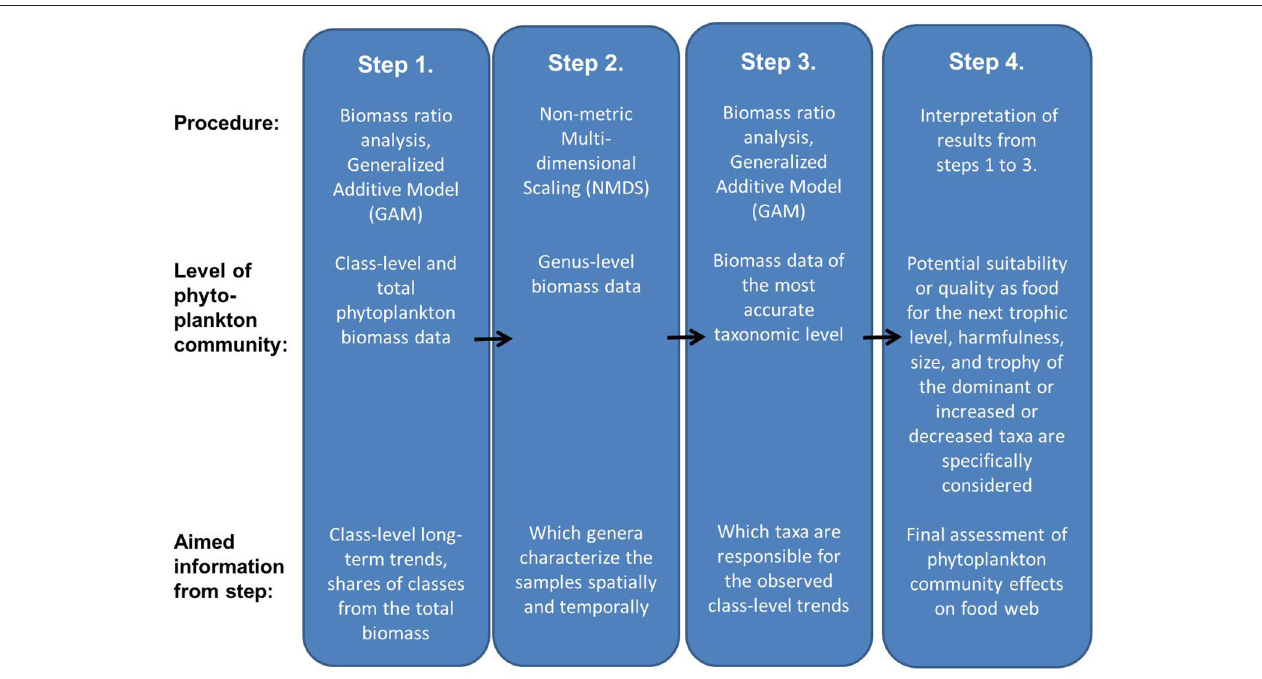
TABLE 1 | A conceptual model of the linkage of phytoplankton community properties (defined as functional characteristics) to high and low trophic transfer efficiency in pelagic food webs (DOM = dissolved organic matter). Phytoplankton community Grazer community Food web structure Transfer efficiency from primary producers to top trophic levels High-quality food items for optimal grazer Optimal for key pelagic fish (e.g., large Direct phytoplankton-based grazing food community (high nutritional value, optimal copepods) chain